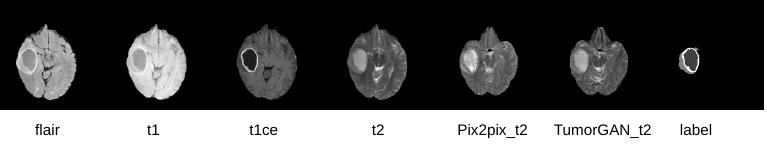
Figure 10. From left to right is the flair, t1, t1ce and t2 modality brain image from the real data. The pix2pix_t2 is the t2 modality image synthesized by the Pix2pix according to the same tumor. The TumorGAN_t2 is generated by TumorGAN. The last column is the segmentation